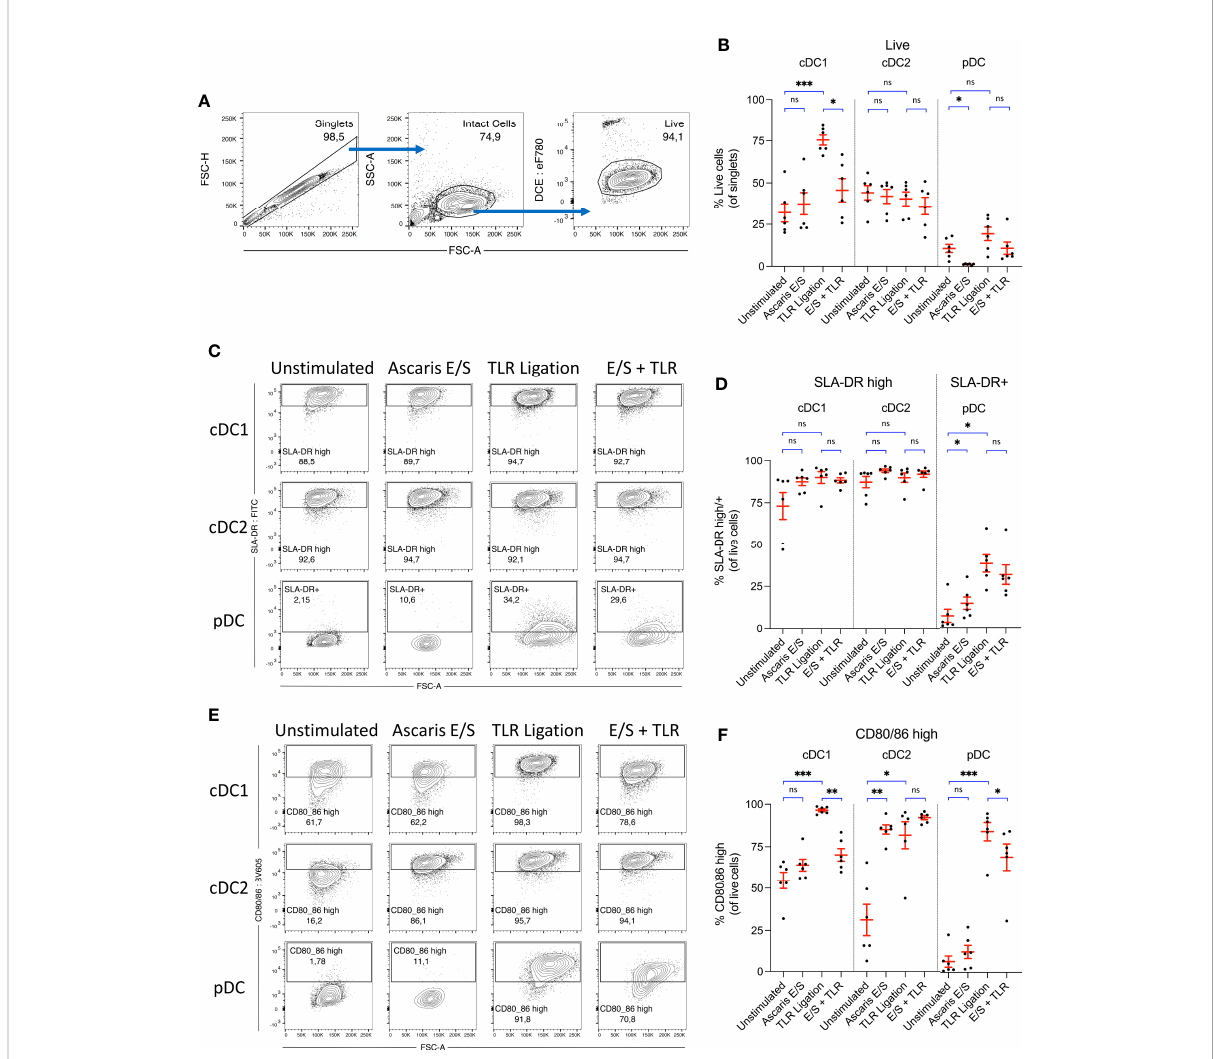
FIGURE 2 Ascaris E/S strongly enhances CD80/86 expression by porcine cDC2, but powerfully inhibits upregulation of CD80/86 by cDC1 following TLR ligation. (A) Representative gating strategy used to identify live, intact cells following 24h incubation of sorted DC subsets. Cell aggregates were excluded, and then intact DC were selected based on size (FSC-A) and granularity (SSC-A). Cells were stained with a fi xable viability dye, and dead cells were excluded. (B) Percentages of viable cells within the total singlet population for each DC subset following incubation without stimulation, stimulation with Ascaris E/S, TLR ligation (100 ng/ml LPS, 500 ng/ml poly(I:C) and 300 ng/ml R848), or combined E/S and TLR stimulation. (C) Representative gating on SLA-DR high cDC1 and cDC2, and SLA-DR+ pDC following each treatment outlined above. (D) Percentages of SLA-DR high cDC1 and cDC2, and SLA-DR+ pDC following each treatment. (E) Representative gating on CD80/86 high cells within each DC subset, following each treatment outlined above. (F) Percentages of CD80/86 high cells for each DC subset and treatment. (B, D, F) Each dot represents a single pig, n = 6. Asterisks indicate statistical signi fi cance by paired t test with Bonferroni correction; *p ≤ 0.017, **p ≤ 0.0033, ***p ≤ 0.00033. ns, not signi fi